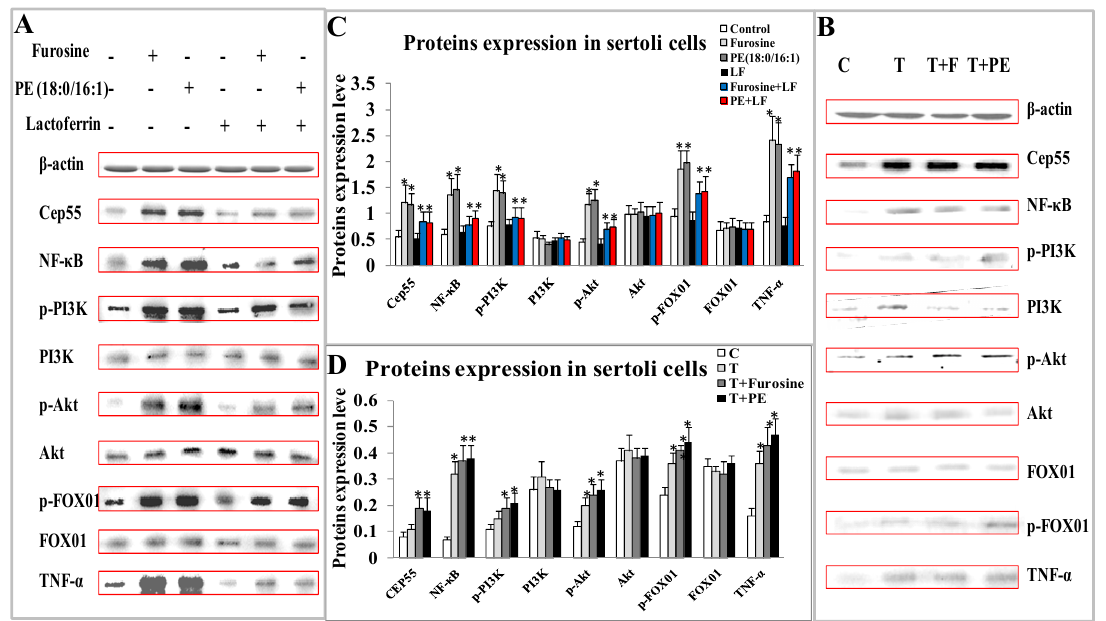
Figure 6. Expression of Cep55, NF- κ B, (p-)PI3K / (p-)Akt, (p-)FOX01, and TNF- α proteins in primary sertoli cells. ( A ) Images of these proteins by western blotting in primary sertoli cells separated from normal mice. ( B ) Images of these proteins by western blotting in primary sertoli cells separated from furosine-treated mice, T stands for sertoli cells separated from furosine-treated mice, F stands for furosine treatment, PE stands for PE(18:0 / 16:1) treatment. ( C ) Protein expressions of these factors in primary sertoli cells separated from normal mice (Figure 6A, analyzed by software). ( D ) Proteins expression level of these factors in primary sertoli cells separated from furosine-treated mice (Figure 6D, analyzed by software), T stands for sertoli cells separated from furosine-treated mice, F stands for furosine treatment, and PE stands for PE(18:0 / 16:1) treatment. All the data were represented as mean ± SD, n = 3. * Comparing with the control, p < 0.05.